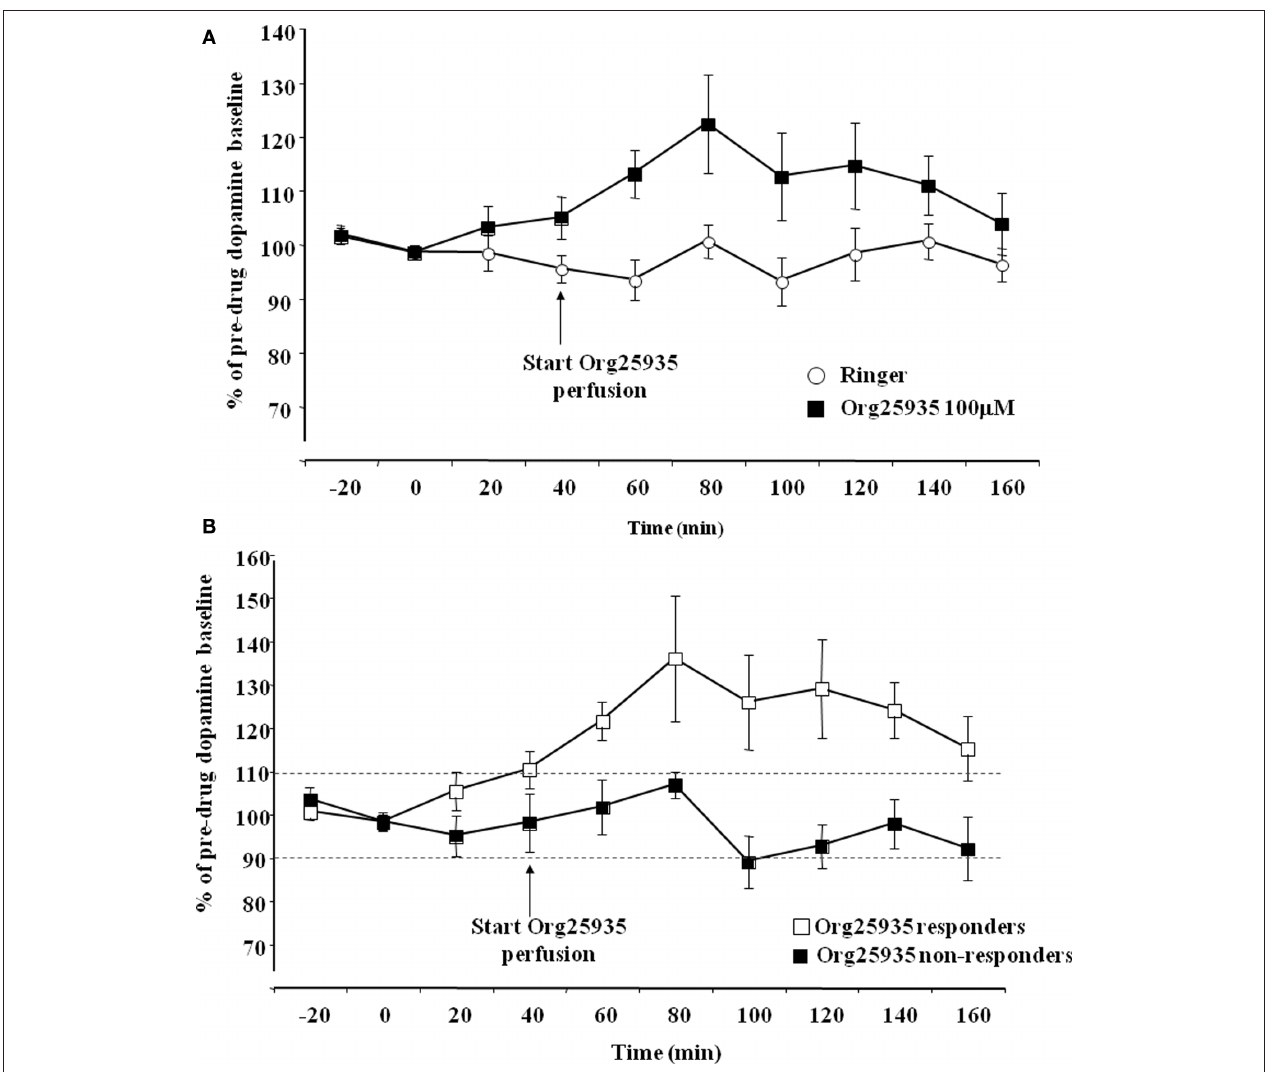
measured by in vivo microdialysis after perfusion of 100 μM Org25935 into nAc in the responding ( n = 7) and non-responding ( n = 6) subgroup, shown as means ± SEM. Drug perfusion started at time point 40 min as indicated by arrow. Basal dopamine concentrations (mean ± SEM) for responders and non-responders were 3.02 ± 1.24 and 2.37 ± 0.55 nM, respectively. For statistics: See Section “Results, Experiment